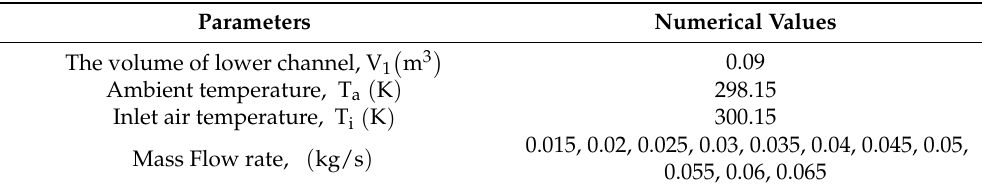
Table 3. The geometrical, thermal, and physical